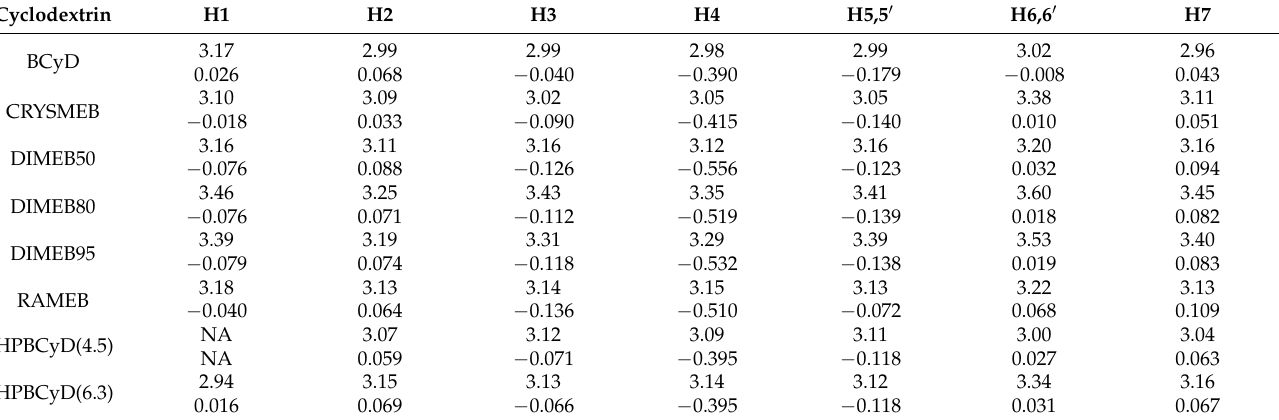
Table 5. The complex stability constants of CyD-fenoprofen complexes (every odd line) followed by the maximal chemical shift response (every even line) obtained from regression fits performed on the data of each individual NMR peak for CyD-fenoprofen complexes. The uncertainty of chemical shift response values (on ppm scale) is on the order of 0.001.